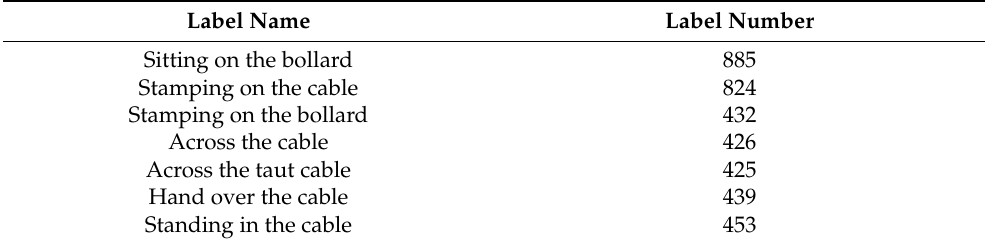
Table 3. Label names and numbers of the dataset.